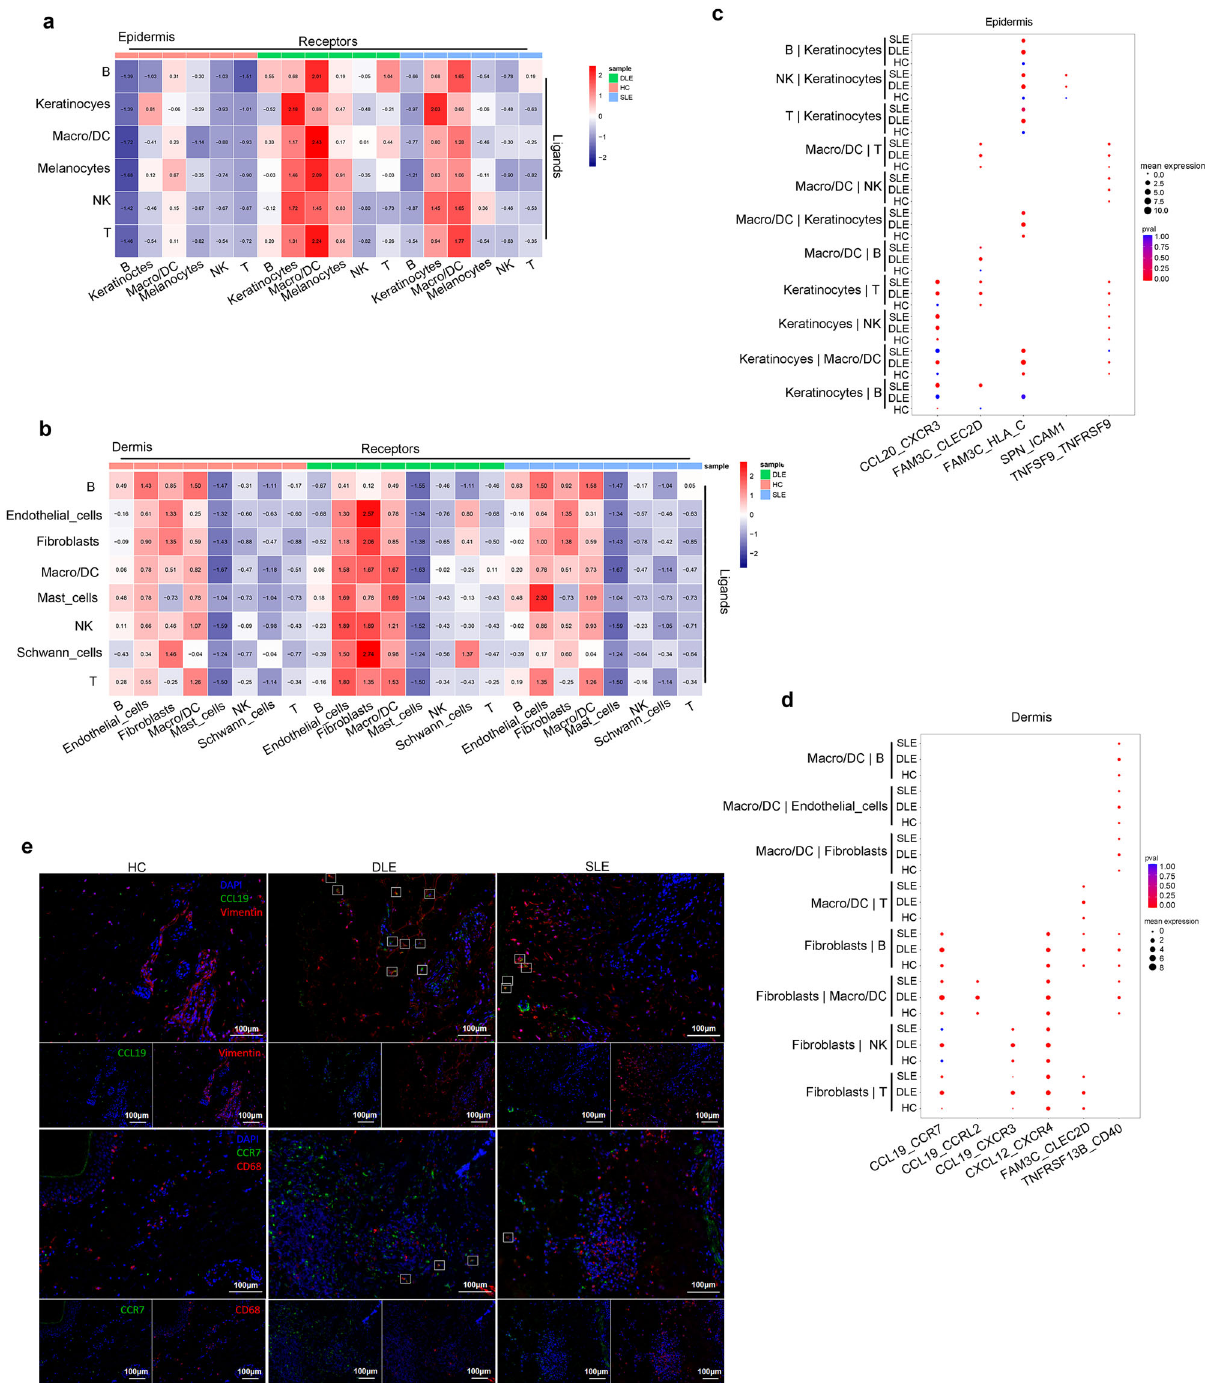
using one-side permutation test. e Represent images show immuno fl uorescence staining for CCL19 (green) expression in fi broblasts (Vimentin, red), CCR7 (green) expressioninmacrophages(CD68,red).Scalebar:100 µ M.Dataarerepresentative of 3 independent experiments. Macro/DC: macrophage/dendritic cell. Source data are provided as a Source Data fi